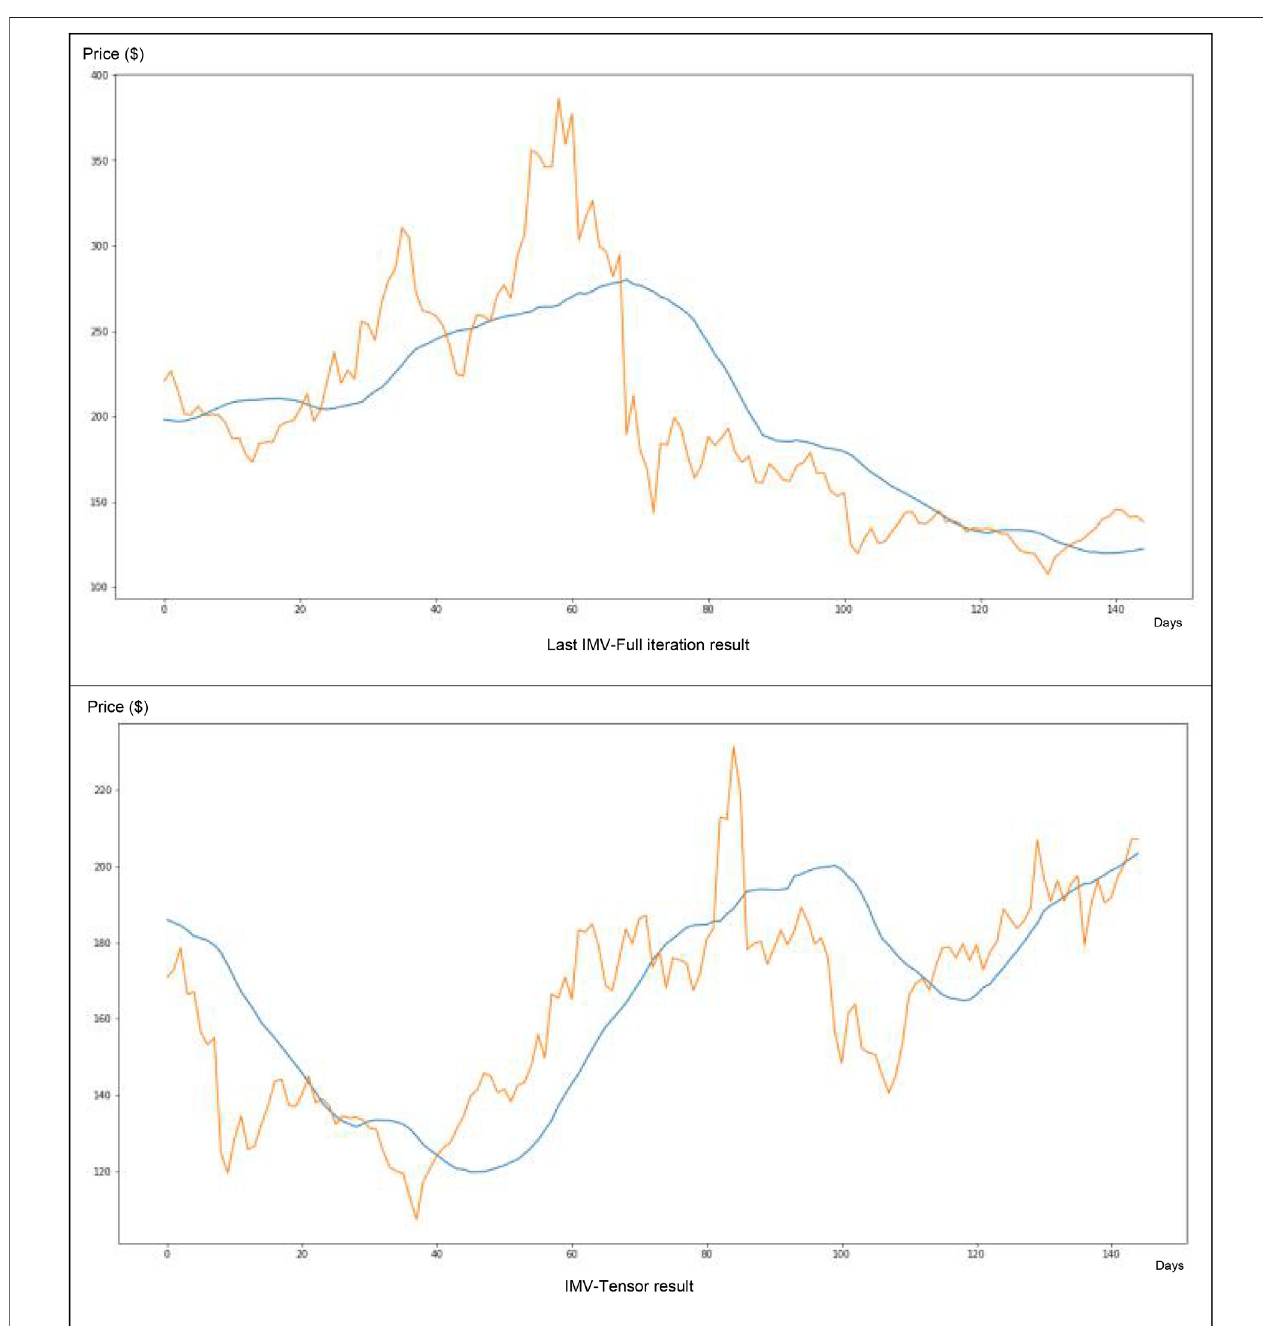
FIGURE 11 | IMV-LSTM application for Litecoin